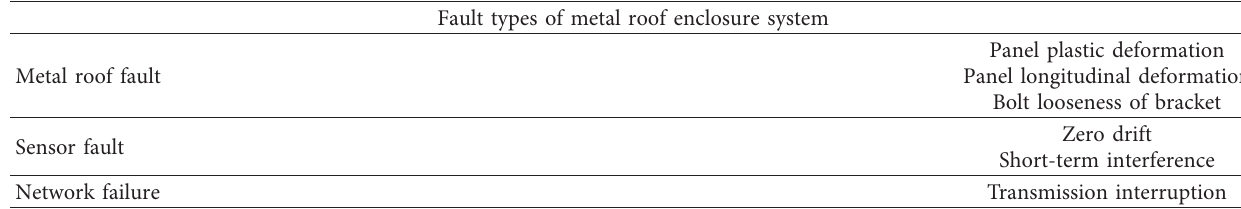
Table 3: Fault types of metal roof enclosure